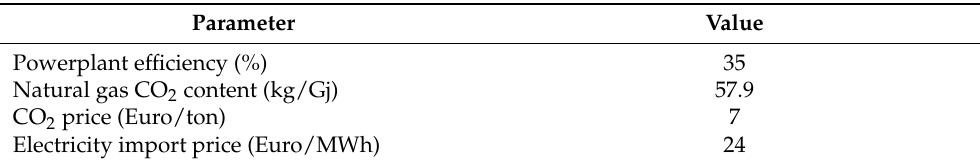
Figure 7. Seven energy plans considered in the paper. In order to model energy and examine the desired scenarios, information such as power plant efficiency and the cost of CO 2 , which is one of the main desired parameters, is presented in Table 2. Table 2. Input parameters for energy modeling